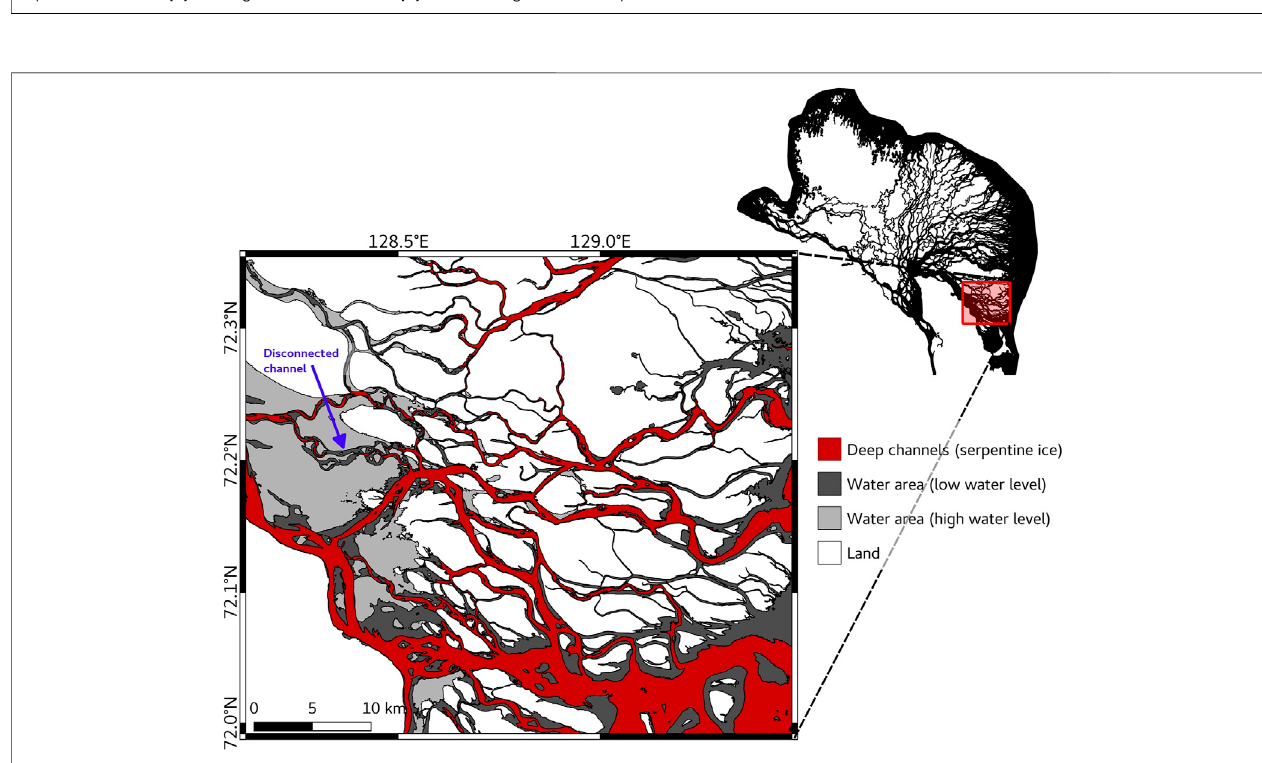
FIGURE 3 | Selected region of the Lena River Delta showing the deep parts of the river channels (red; winter SAR imagery), channel area during low water period (dark gray; optical imagery), and channel area during high water level (light gray; summer SAR imagery).